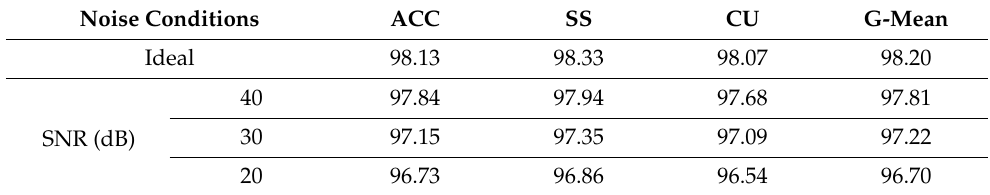
Table 7. RCNN metrics under noise